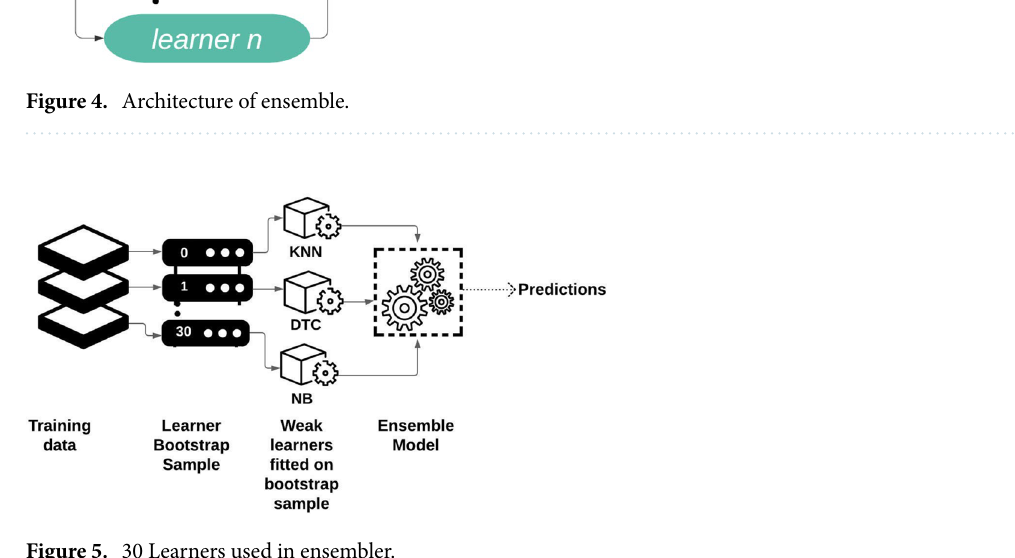
Figure 5. 30 Learners used in